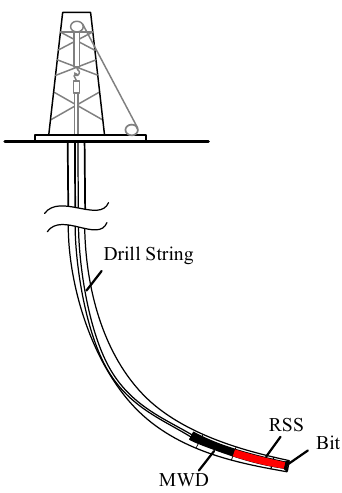
Figure 1. Schematic of the directional drilling system.